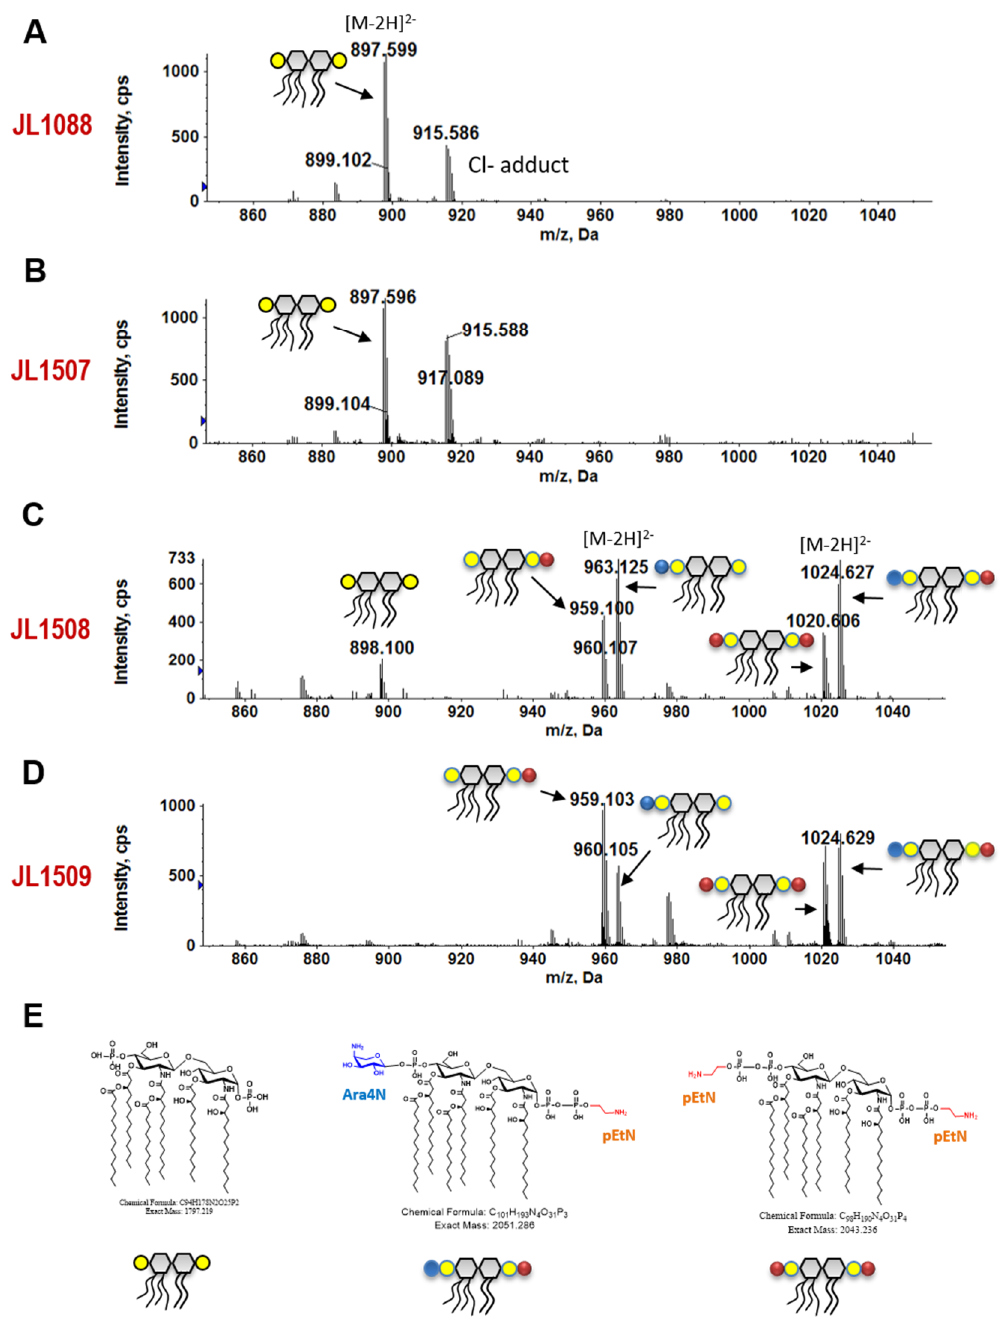
Figure 3. MS analysis of lipid A in the E. coli TOP10 strains bearing pmrB BL21 with different lengths of downstream regions. The doubly charged [M-2H] 2− ions of lipid A species are shown. ( A ) Unmodified lipid A in JL1088, the control strain containing pZE21 vector only; ( B ) Unmodified lipid A in JL1507, which contains plasmid pUS150-PmrB-DS86; ( C ) Extensive modifications of lipid A by Ara4N and pEtN in JL1508, which contains plasmid pUS150-PmrB-DS103; ( D ) Extensive modifications of lipid A by Ara4N and pEtN in JL1509, which contains plasmid pUS150-PmrB-DS126. The pmrB carried in three recombinant plasmids are diagramed in Figure 1A. ( E ) Representative chemical structures and the corresponding cartoons of hexa-acylated lipid A and its Ara4N and pEtN modifications.